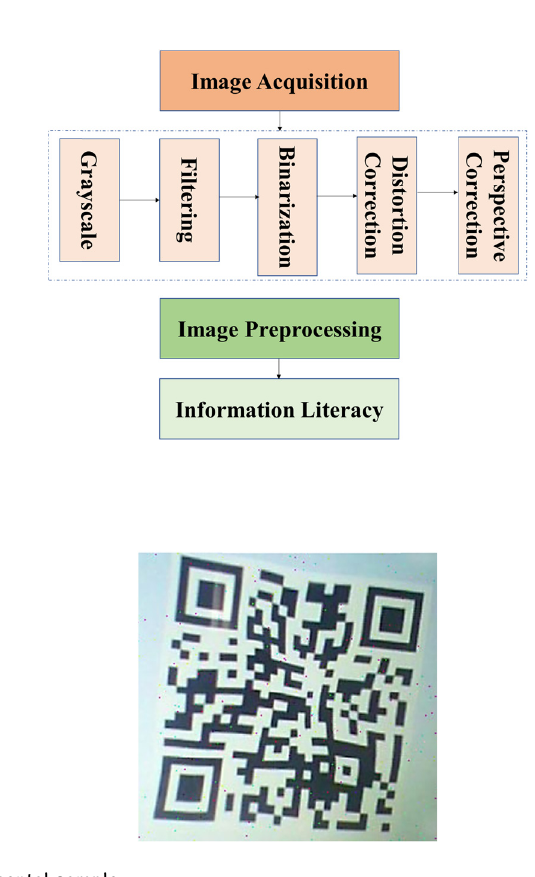
Figure 7: QR image of experimental sample.